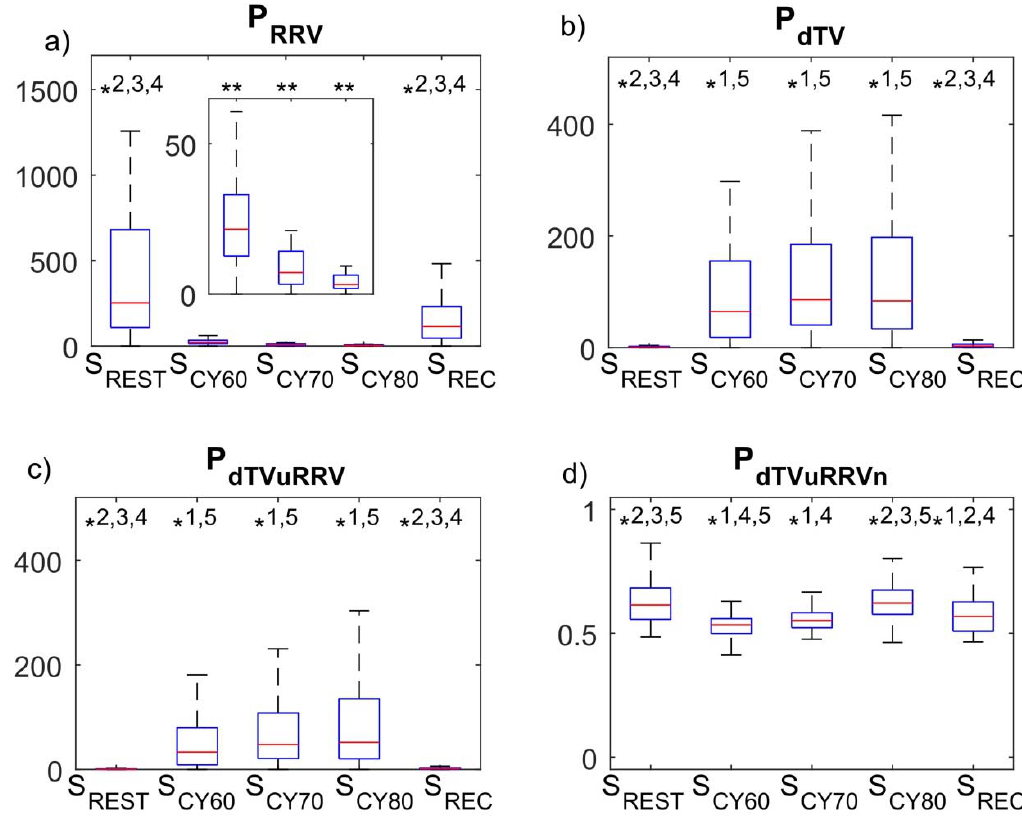
Figure 5. Box plots representing the distributions of P RRV , P dTV , P dTVuRRV and P dTVuRRVn (N = 66) over the study population (N = 66) for the different test segments: resting (S REST ), cycling (S CY ) and recovery (S REC ). S CY was divided into three stages corresponding to 60, 70 and 80% of estimated HR max , denoted as S CY60 , S CY70 and S CY80 . ( a ) LF oscillations of RR variability (P RRV ), with the inset showing the three S CY stages. ( b ) LF oscillations of dT variability (P dTV ). ( c ) P dTV unrelated to P RRV (P dTVuRRV ). ( d ) Normalized P dTV unrelated to P RRV (P dTVuRRVn ). * = Significant differences between test segments ( p ≤ 0.05, Friedman’s ANOVA): * 1 = Different to S REST ; * 2 = Different to S CY60 ; * 3 = Different to S CY70 ; * 4 = Different to S CY80; * 5 = Different to S REC; ** = Different to all.